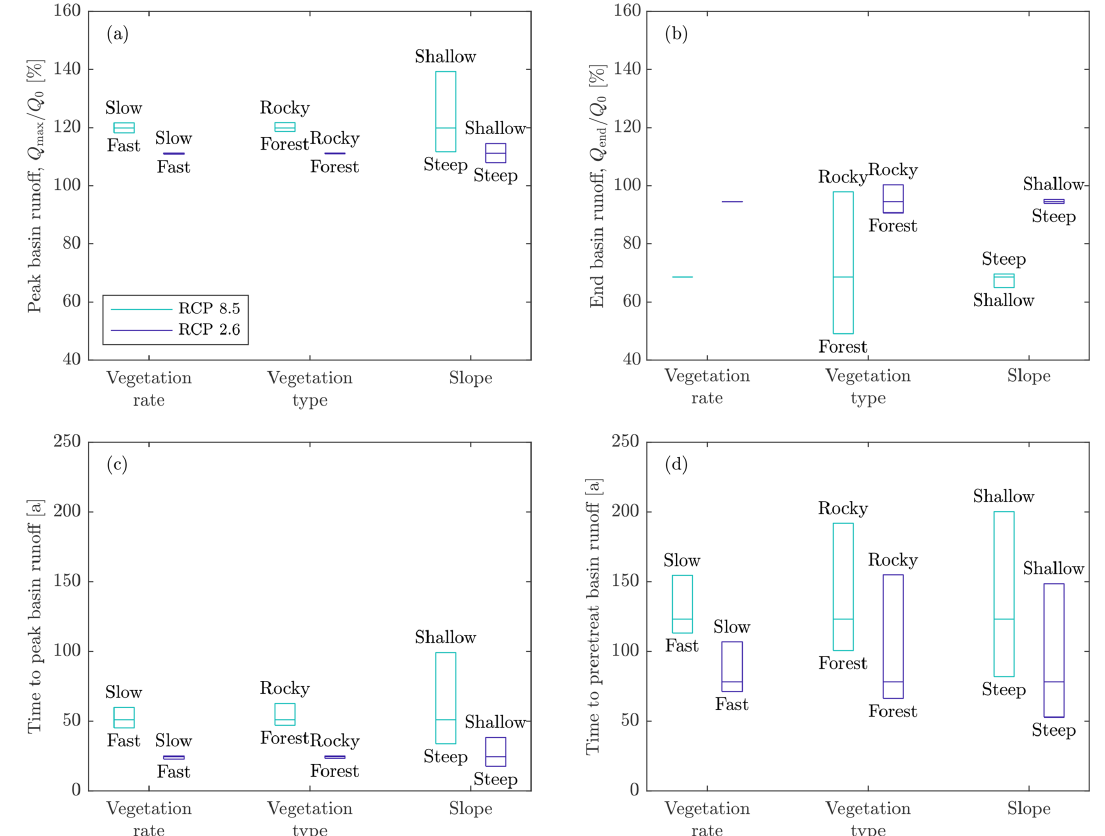
Figure 6. Influence of catchment vegetation and basin slope on our hydrologic metrics: (a) peak basin runoff, (b) end basin runoff, (c) time to peak basin runoff, and (d) time to preretreat basin runoff. We varied vegetation rate (slow to fast), vegetation type (rocky/unvegetated to forest), and slope (shallow to steep) across the ranges shown in the legends of Figs. 3–5. The boxes represent the timing and relative magnitude of basin runoff associated with varying each parameter, and the lines within each box represent the value for the canonical simulation (maritime climate, basin slope of 5 ◦ , C = { 1 , 0 . 9 , 0 . 8 , 0 . 6 } , and T = { 15 , 30 , 50 } ).